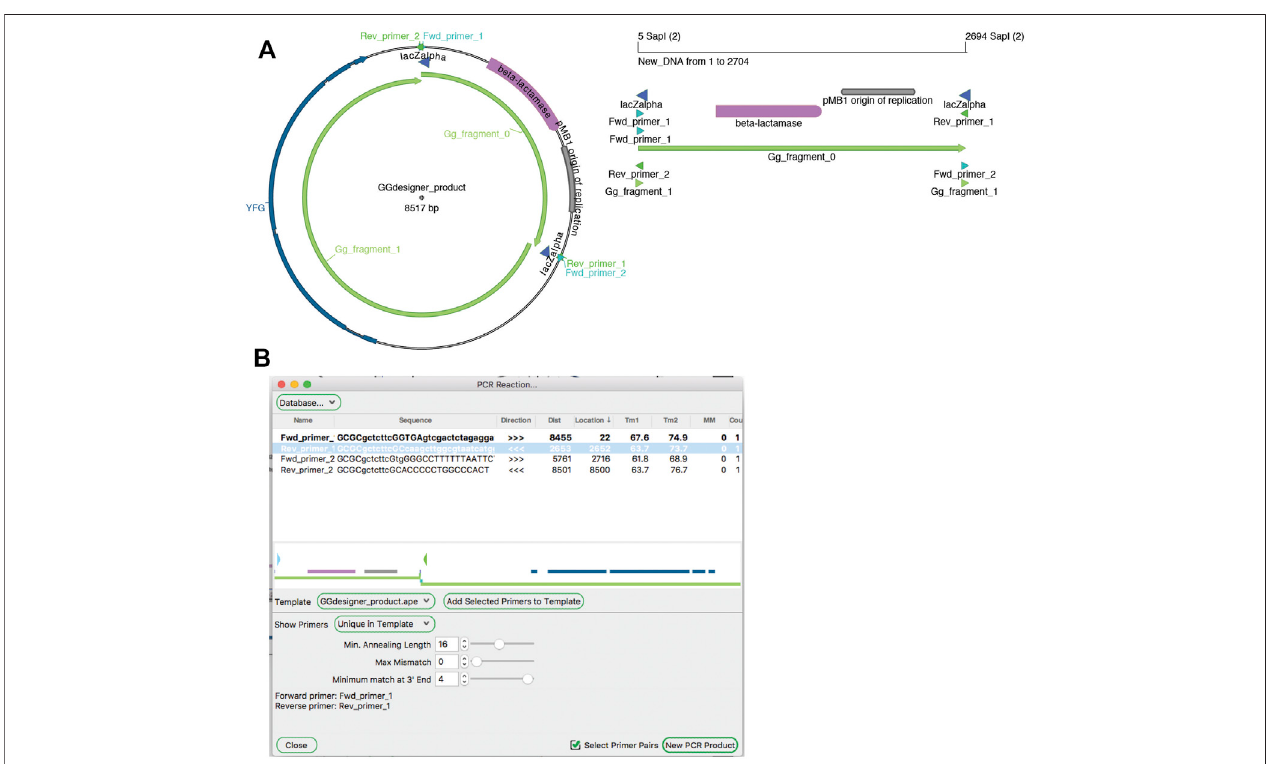
FIGURE9| PCRReactiontool. (A) AgraphicmapoftheGoldenGateproductfrom Figure5 (left),whichcanbeusedasaPCRtemplate. AgraphicmapofaPCR product generated with the PCR tool (right) (B) The PCR reaction tool shows a map of the template in the center, and a table of possible PCR products at the